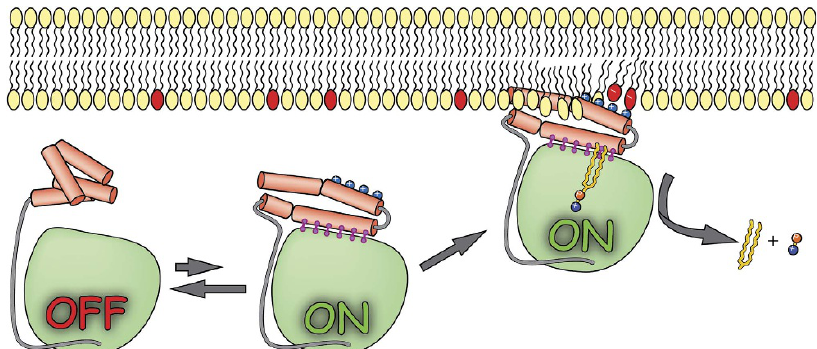
Figure 8 | Schematic for ASMase activation. Membrane lipids that have red head groups indicate negative charges. Released products are ceramide (yellow worm) and phosphocholine (orange and blue circles). recommended. The second step was carried out at 37 (cid:2) C and the change in mixed with an equal volume of well solution. Crystals of murine ASMase with the fluorescence (560nm excitation and 590nm emission) after 30min was used to saposin domain in an open conformation ( B 200 (cid:3) 25 (cid:3) 25 m m in size) were quantify product formation with the help of a phosphocholine standard curve. obtained in 100mM sodium MES (pH 6.5) and 1.5M ammonium sulfate. The same protein with the saposin domain in a closed conformation was crystallized Crystallization and data collection . Crystals were grown by sitting drop or hanging drop vapour diffusion at 22 (cid:2) C. Protein at 10mgml (cid:2) 1 in buffer B was